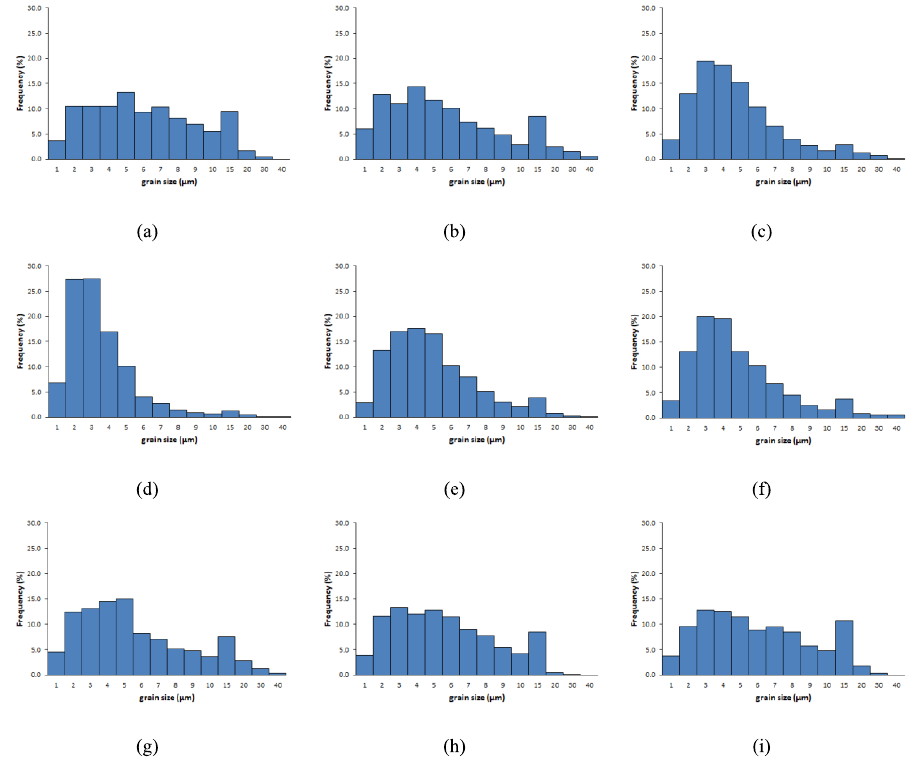
Figure 8. Grain size histograms for aged samples: ( a ) 150 °C for 1 h; ( b ) 150 °C for 6 h; ( c ) 150 °C for 12 h; ( d ) 175 °C for 1 h; ( e ) 175 °C for 6 h; ( f ) 175 °C for 12 h; ( g ) 200 °C for 1 h; ( h ) 200 °C for 6 h and ( i ) 200 °C for 12 h.